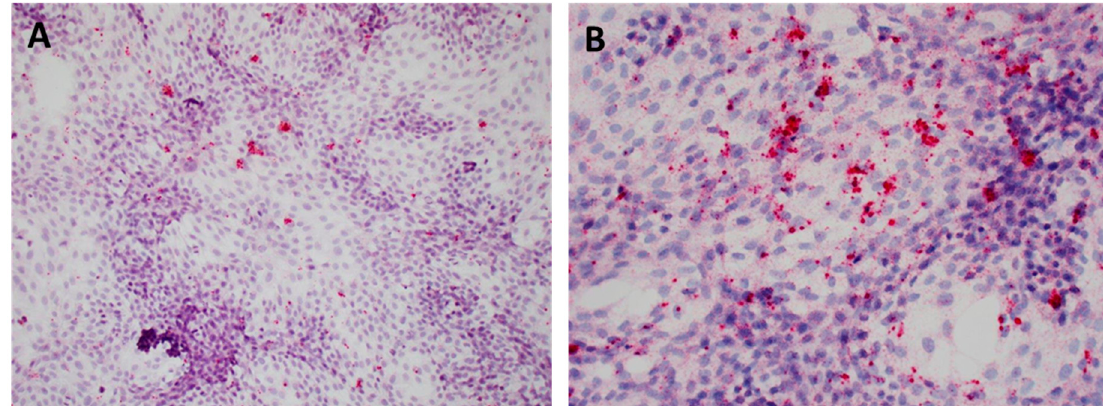
Figure 3. PK-15 infected cells show strong intracytoplasmic hybridization signal. ( A ) An RNA cocktail probe targeting PCV3 ORF2 showed positive signal (red) in individual cells and occasionally clustering cells (20×). ( B ) Positive cells are characterized by small red dots diffusely distributed in the cytoplasm of epithelial cells (40×). Negative cells in purple.